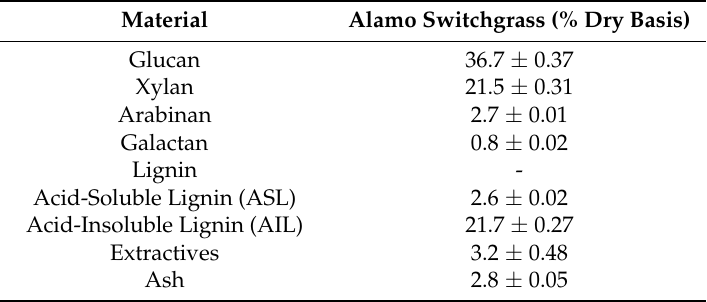
Table 1. The composition of Alamo Switchgrass.